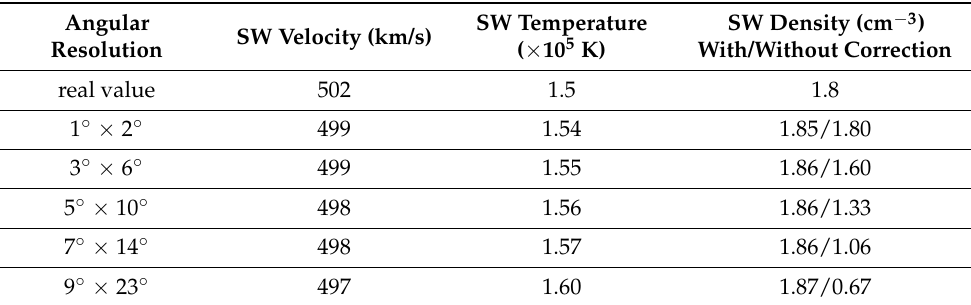
Table 3. Inversed SW parameters under different angular resolutions.